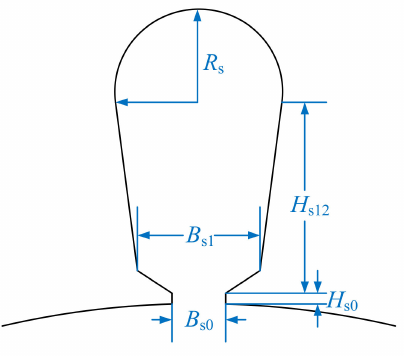
Figure 5. Size of 120 ◦ PBTWSRIM